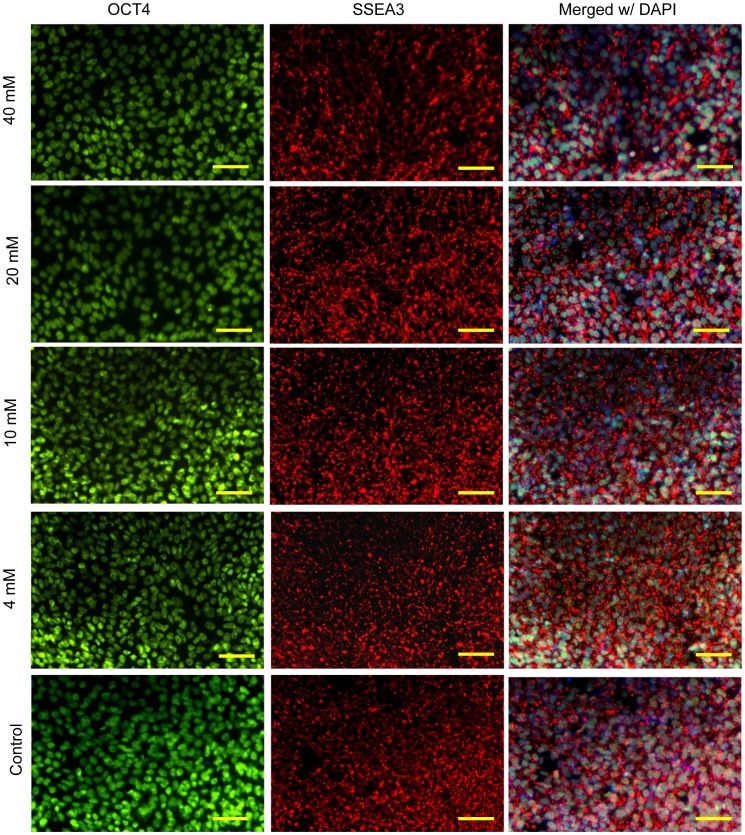
Media pH and Mg ion concentrations in the post-culture media collected at every 24 hours after hESCs were cultured in the media supplemented with Mg ion dosages.(A) Average pH and (B) Mg ion concentrations in the post-culture media when the supplemental Mg ion dosages ranged from 0.4–40 mM (*p<0.05 compared to the control at each time point respectively). Values are mean ± standard deviation; n = 3. The cell counts in the hESC cultures supplemented with 30 and 40 mM Mg ions were statistically lower than the cultures with lower Mg ion dosages and the control, and, therefore, less acidic metabolites formed and the pH values were statistically higher. Additionally, statistically greater Mg ion concentrations were observed in the post-culture media at the critical Mg ion concentration of 10 mM and above, as compared with the control, 0.4 mM and 4 mM media conditions at each respective time point.